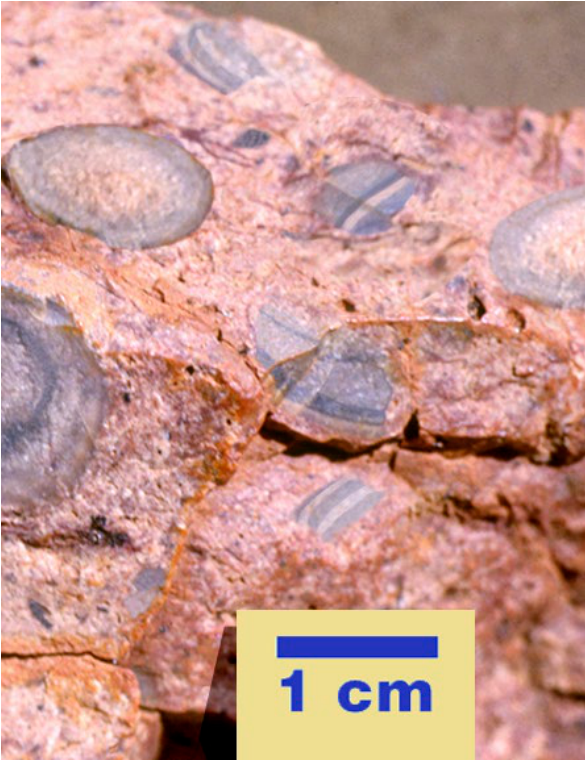
Figure 5. Banding in Black Angel porphyroid chert ovoids was formed before some were broken in subsequent liquefaction of the matrix. The bands were not formed by exposure and